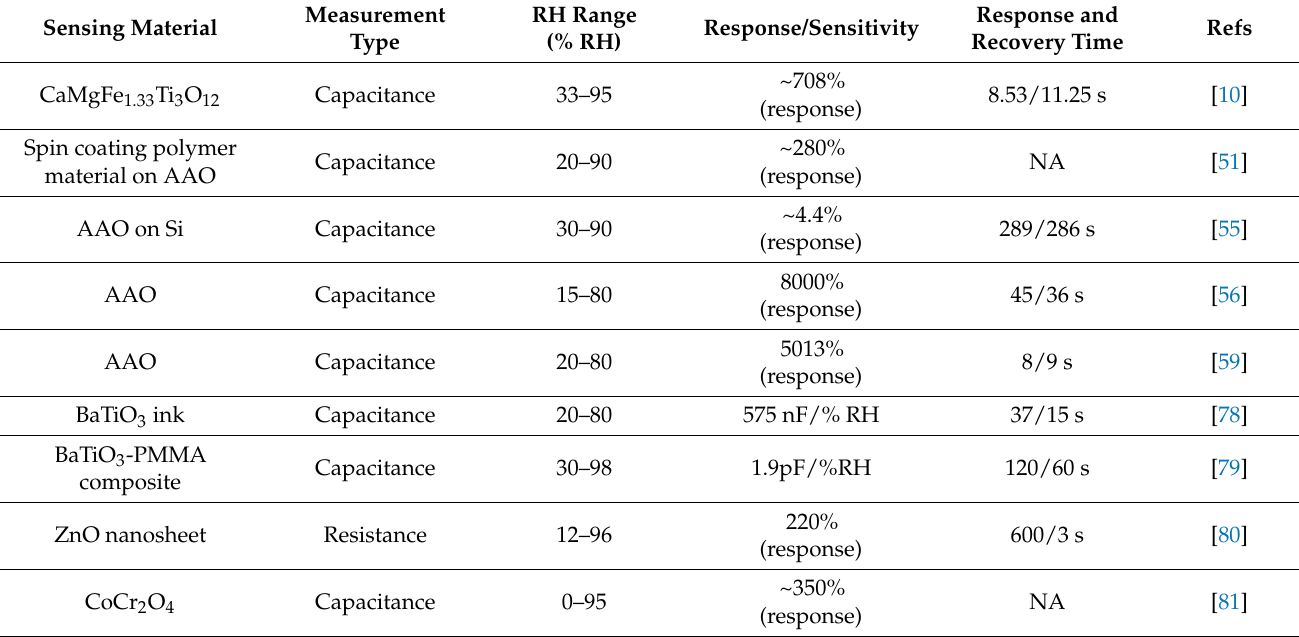
Table 1. Ceramic-sensor performance comparison in measurement type, response/sensitivity and response and recovery